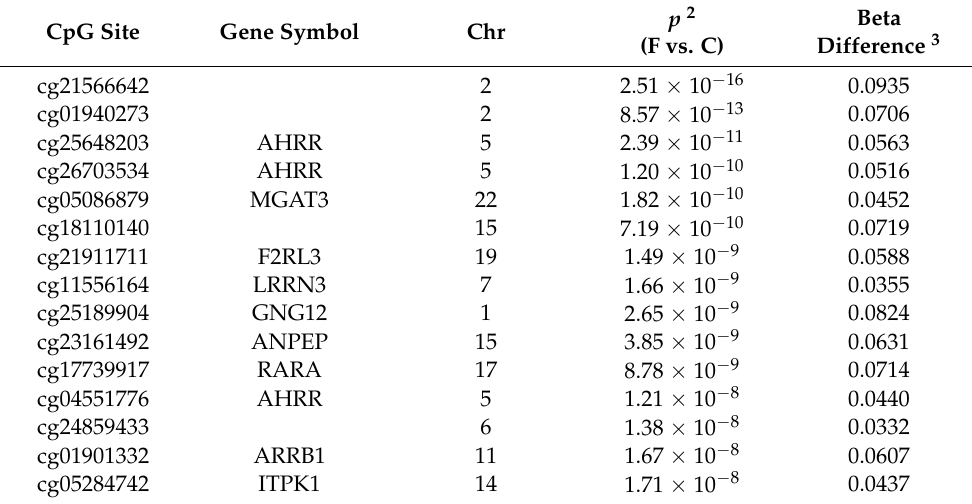
Table 4. Top-ranked (15) differentially methylated CpGs for former smokers (F) relative to current smokers (C) ranked by smallest p -value after multivariate adjustment 1